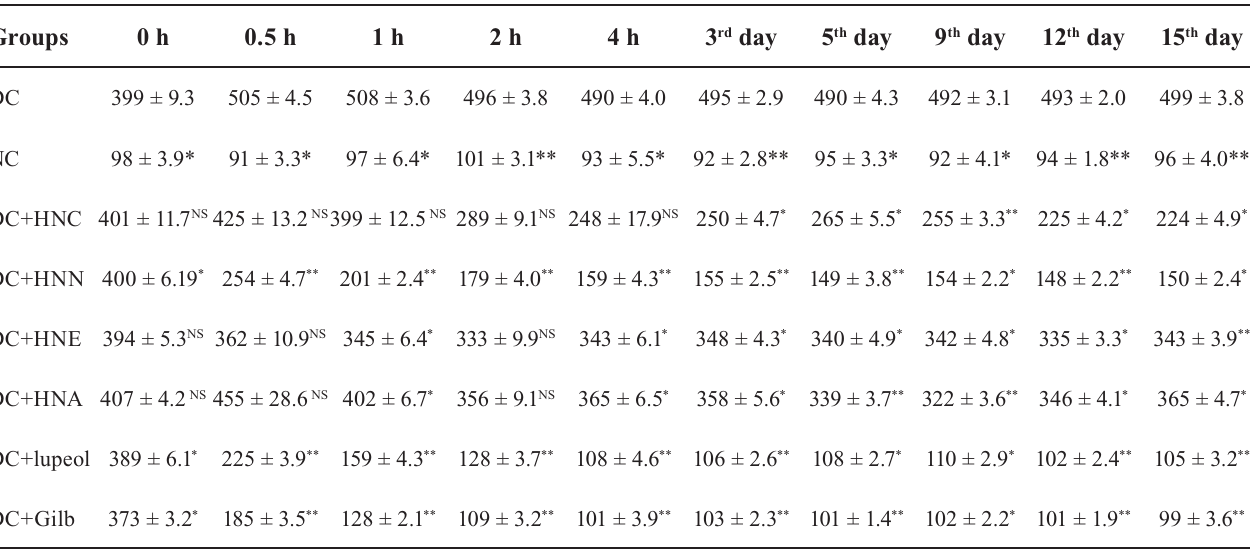
TABLE I - E ffect of H. nepalensis extracts and lupeol on blood glucose level (mg/dL) in alloxan induced diabetic rats